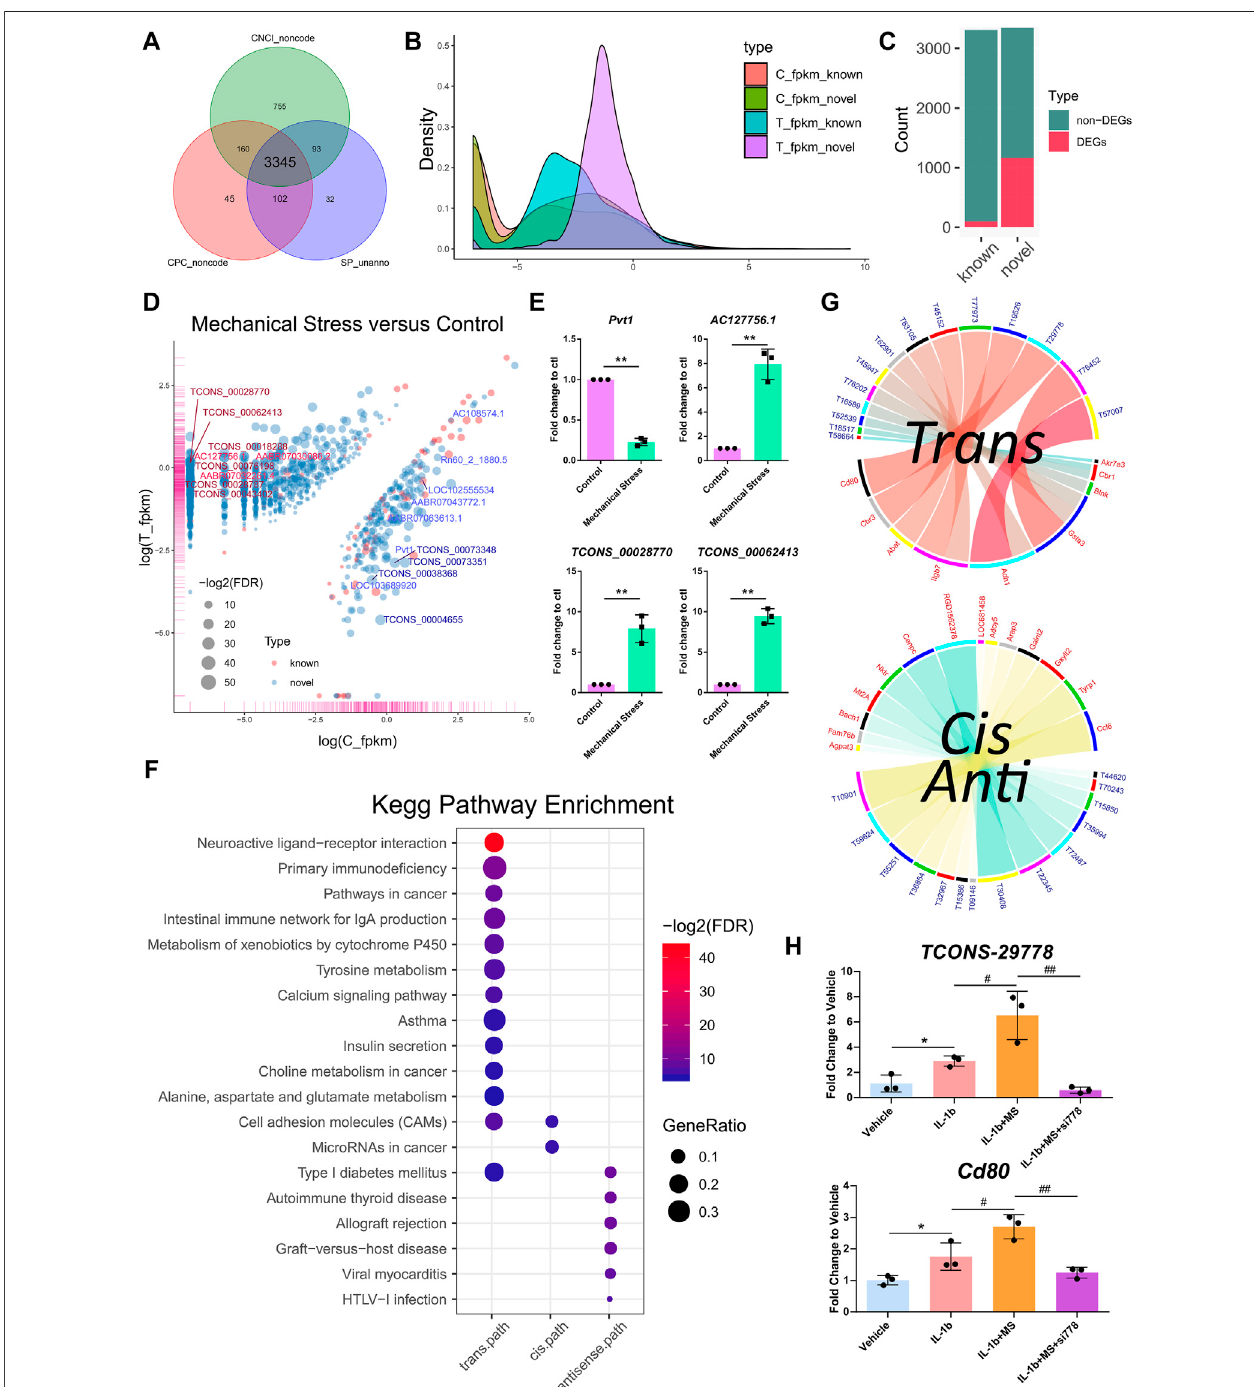
FIGURE 3 | Novel lncRNAs emerged as a key response to mechanical stress. (A) A total of 3,345 novel lncRNAs are identi fi ed by software CNCI, CPC, and the SwissProtdatabase. (B) ThedensityplotofthegeneexpressionoftheknownandthenovellncRNAs.MechanicalstressincreasestherelativelyhighexpressedlncRNAs and decreases the relatively low expressed lncRNAs, including the known and the novel lncRNAs. The novel lncRNAs are the most signi fi cantly altered composition responsivetomechanicalstress. (C) Thenumbersofthenon-DELsandDELsintheknownandthenovelgroups.ThenumberofDELsinthenovelgroupisnotably higher than the known group. (D) The volcano plot of DELs with FDR < 0.05 and log 2 FC > 1 or < − 1 in the comparison of mechanical stress versus control. The red bubblerepresentstheknownlncRNA.Theblue bubble represents thenovellncRNA.Theupregulated knownand novellncRNAs arelabeled bybrightred anddarkred, respectively. The downregulated known and novel lncRNAsare labeled bybrightblue and dark blue, respectively. (E) RT-PCR validation ofthe known lncRNA Pvt1 and AC127756.1 and the novel lncRNA TCONS_00028770 and TCONS_00062413 . * p < 0.05, ** p < 0.01, two-tailed Student ’ s t -test, mechanical stress versus control. (F)